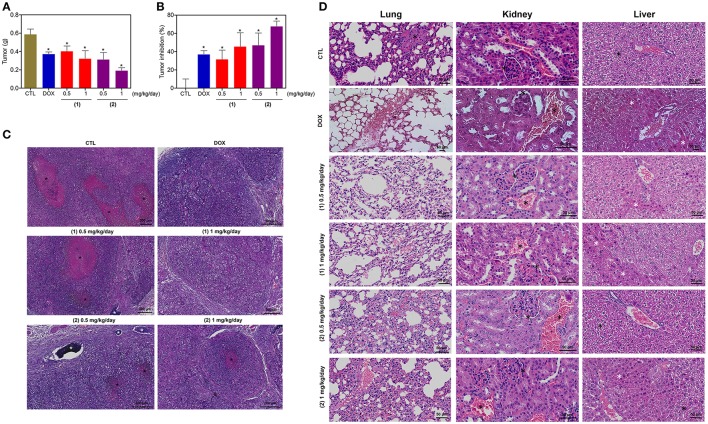
In vivo antitumor activity of ruthenium complexes containing heterocyclic thioamidates in C.B-17 SCID mice with HepG2 cell xenografts. (A) Quantification of the tumor weight (g). (B) Quantification of the tumor inhibition (%). Data are presented as the mean ± S.E.M. of 8–10 animals. *P < 0.05 compared with the negative control, as determined by ANOVA followed by the Student-Newman-Keuls test. (C) Representative histological analysis of the tumors that were stained with hematoxylin and eosin and analyzed by light microscopy. The areas of necrosis and dystrophic calcification are represented by black and white asterisks, respectively. (D) Representative histological analysis of the lungs, kidneys and livers that were stained with hematoxylin and eosin and analyzed by light microscopy. Black asterisks represent metastasis (lung), the thickening of the basal membrane of the renal glomerulus with decreased urinary space or vascular congestion (kidney) and hydropic degeneration (liver). White asterisks represent the coagulation necrosis of hepatic cells. The negative control (CTL) was treated with the vehicle (5% DMSO) that was used to solubilize and dilute the complexes, and doxorubicin (DOX, 0.3 mg/kg/day) was used as the positive control. Beginning 1 day after tumor implantation, the animals were treated via an intraperitoneal route for 21 consecutive days.